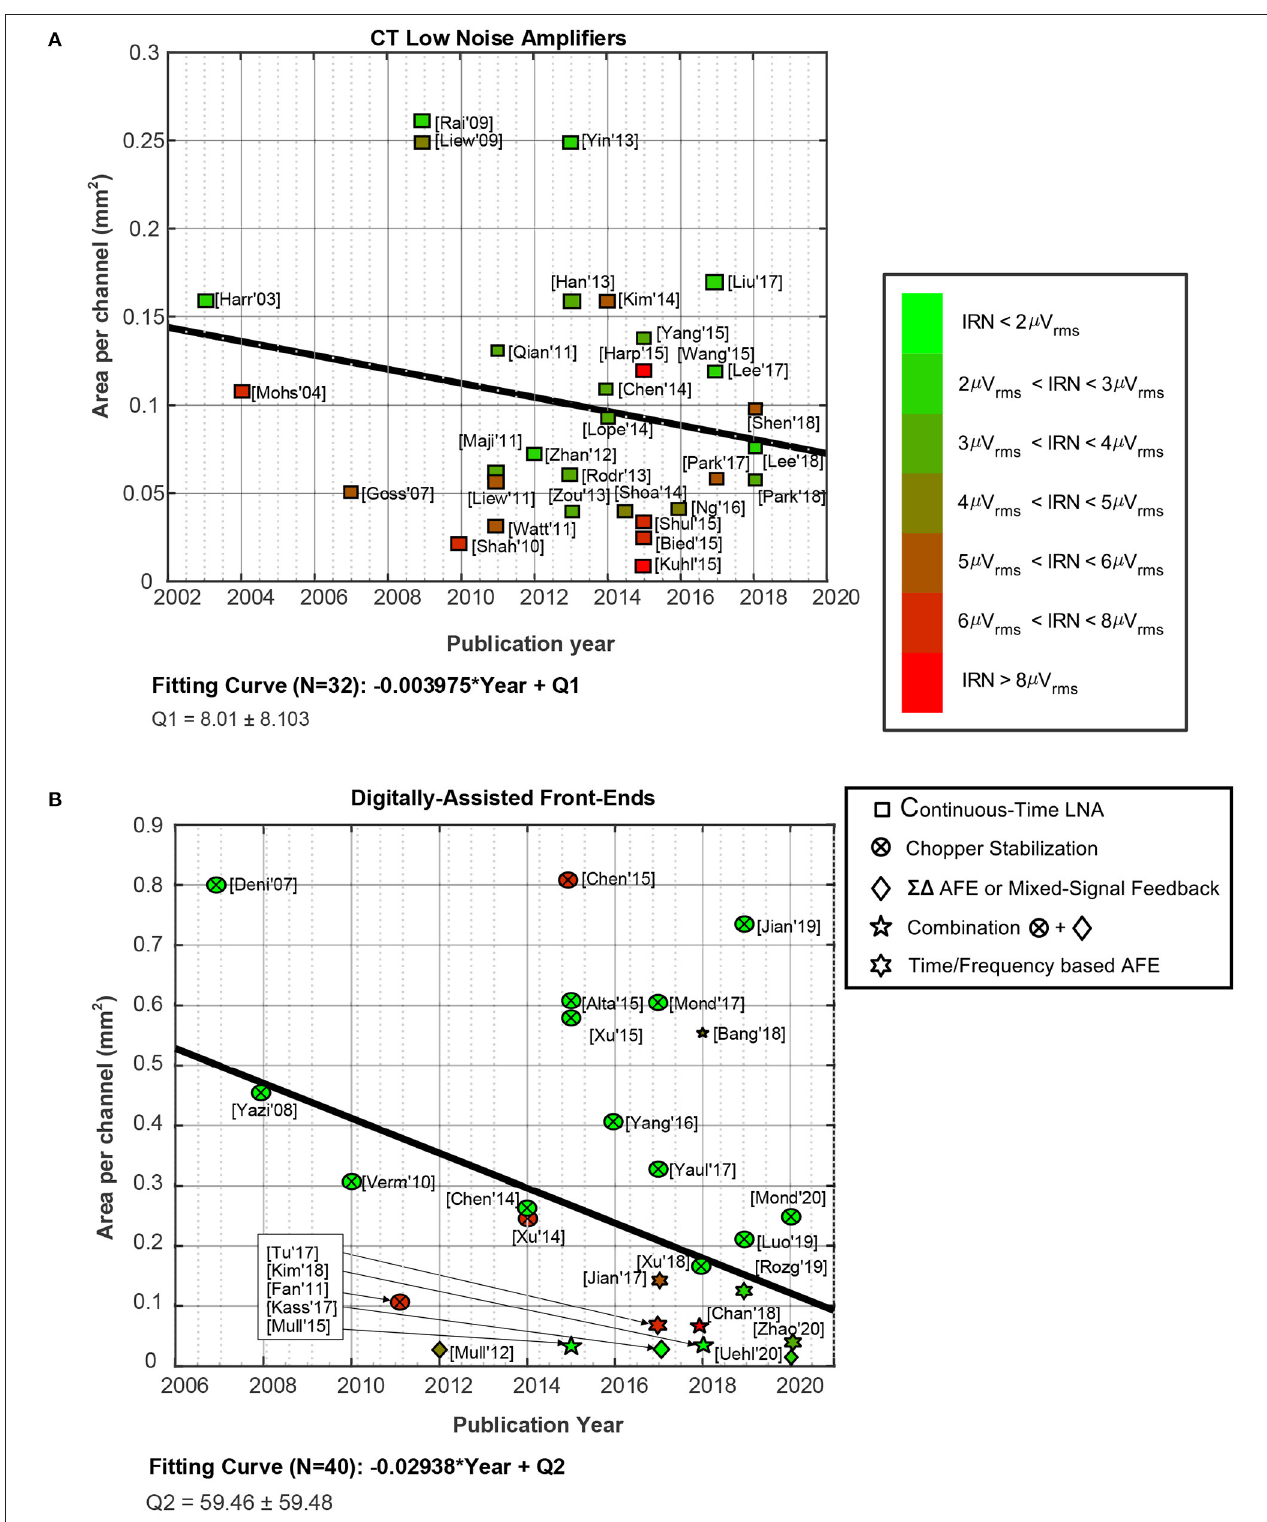
FIGURE 5 | Evolution of the form factor of neural AFEs over the years. The green-red scale indicates the value of the IRN of each reported circuit. Fitting curves represent the trend over the years of the area per channel. (A) For CT LNAs. (B) For digitally-assisted AFEs.